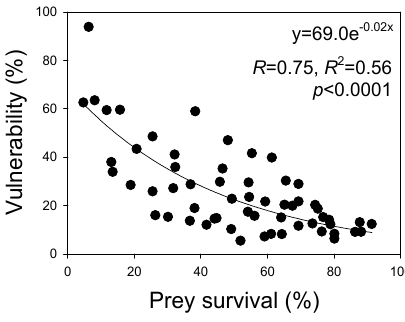
Figure 5. Correlation of vulnerability and prey survival drawn in this study.